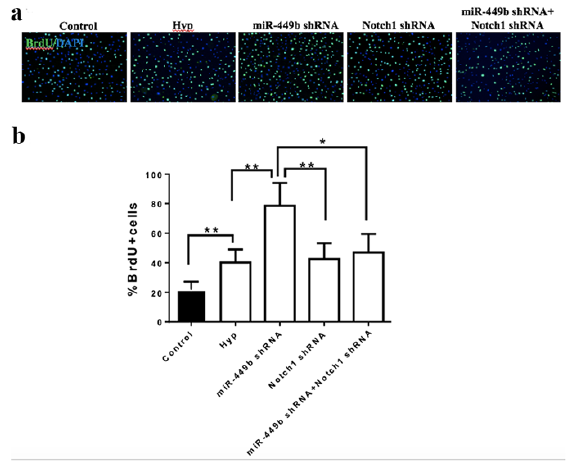
Figure 9. miR-449b/Notch1 signaling pathway modulated NE-4C proliferation. ( a ) Representation of immunofluorescence staining. ( b ) Bar graph shows BrdU-positive cells. N = 6 per group. * p < 0.05, ** p < 0.01.